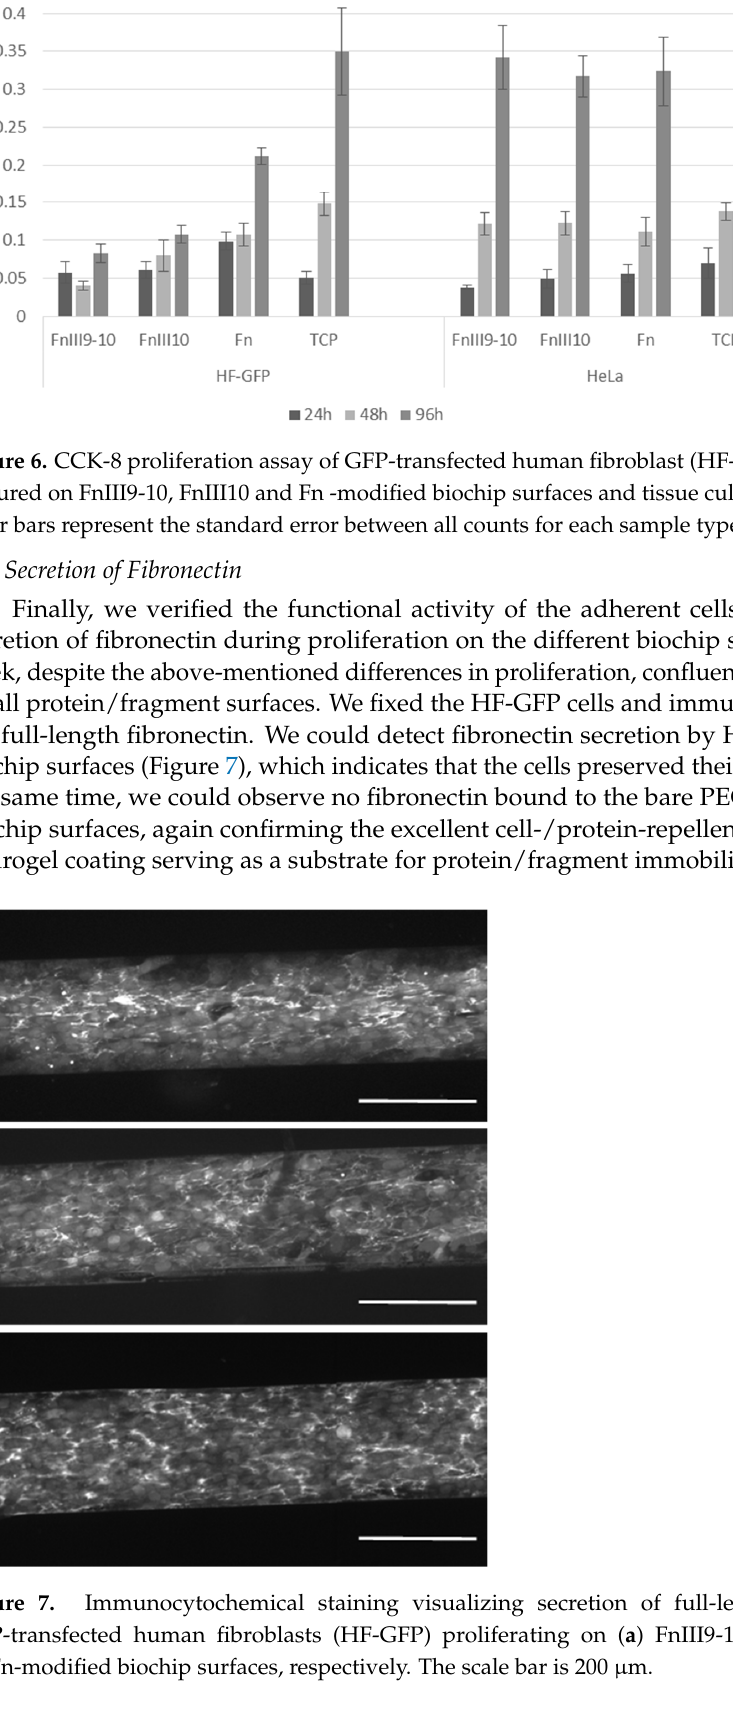
10 of 15 Figure 5. Statistical analysis of single GFP-transfected human fibroblast (HF-GFP) and HeLa cells adherent onto FnIII9-10, FnIII10 and Fn-modified biochip surfaces and tissue culture plate (TCP). The cells were immunostained for vinculin. The focal adhesion area per cell was calculated accord- ing to the number of vinculin points. The data are presented as mean ± standard error of between 83 and 335 cells from 4–7 samples of each type. * marks a statistically significant difference compared to the samples of the same cell type grown on Fn and TCP, ∧ —compared to the samples on TCP, #—compared to Fn (projected cell area), #—compared to Fn domains (focal adhesions area per cell). ANOVA with post hoc LSD test, p < 0.05. 3.3. Proliferation To estimate cell proliferation, we employed the CCK-8 assay (Figure 6). Again, HF- GFP proliferation on the FnIII9-10 and FnIII10 surfaces was similar, at least with the se- lected period of 96 h. Notably, the HF-GFP cells on the Fn surfaces proliferated faster, and at 96 h, the optical density (OD) value was 2–2.5 times higher than in the case of FnIII9-10 and FnIII10. The cells on the TCP plate had the largest area to proliferate, and this could explain the observed highest OD value at 96 h. Contrary to the HF-GFP culture, the HeLa cells within the error range showed a sim- ilar proliferation rate on all types of surfaces and TCP plates within the course of the ex-